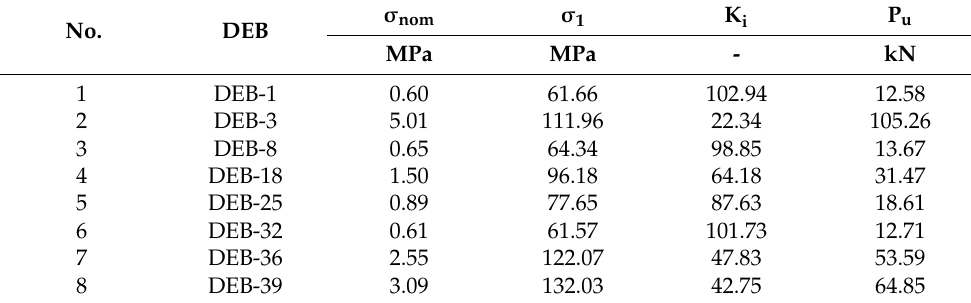
Table 5. The stresses and SCF of RC-DEBs based on RSG-B data.